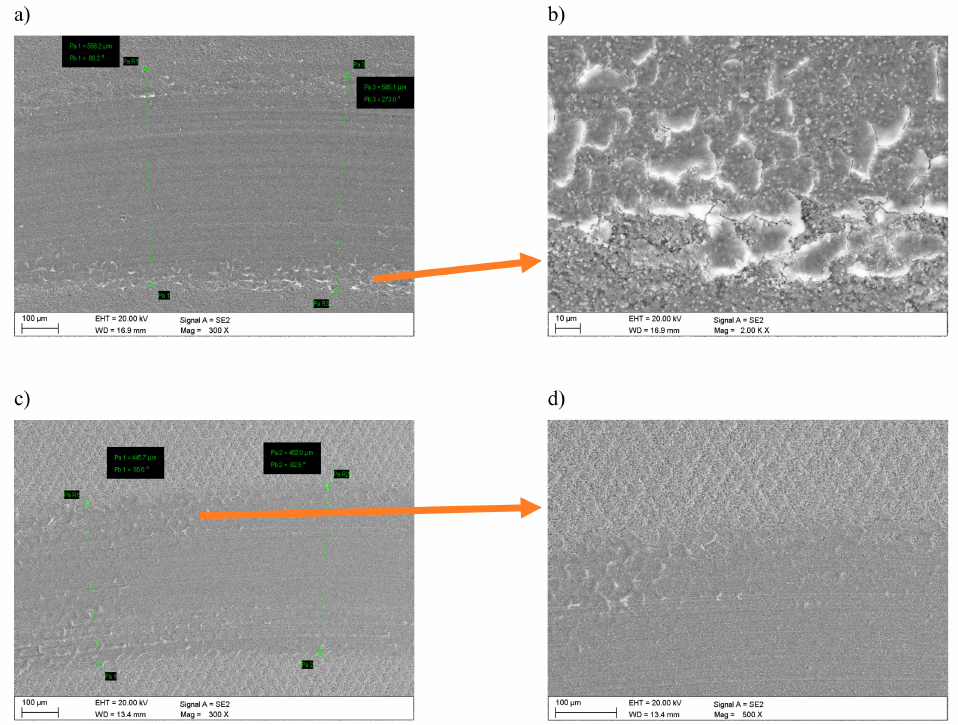
Figure 8. Wear resistance of sialon ceramics ( a , b ) before laser texturing, ( c , d ) after laser texturing.